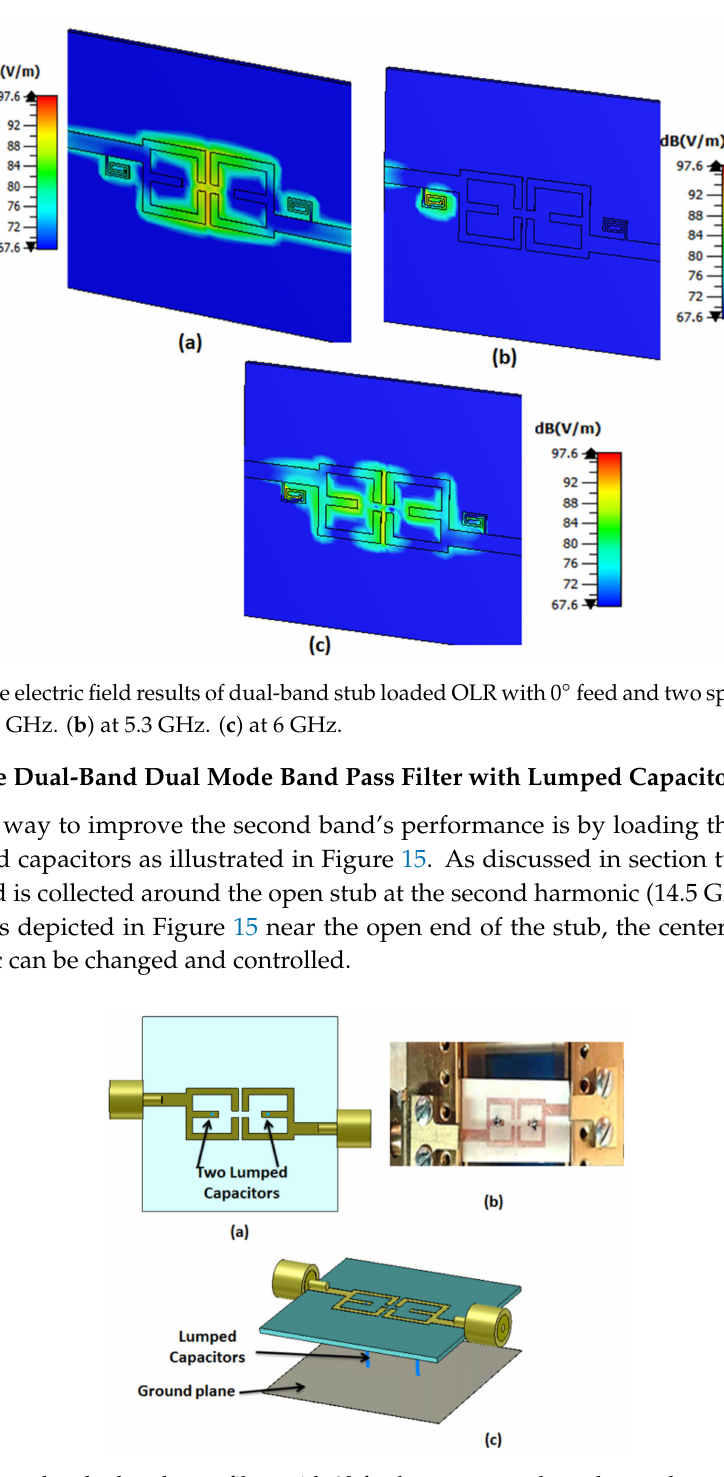
Figure 15. Second-order band-pass filter with 0 ◦ feed structure and two lumped capacitors. ( a ) 2-D configuration. ( b ) Fabricated photo. ( c ) 3-D